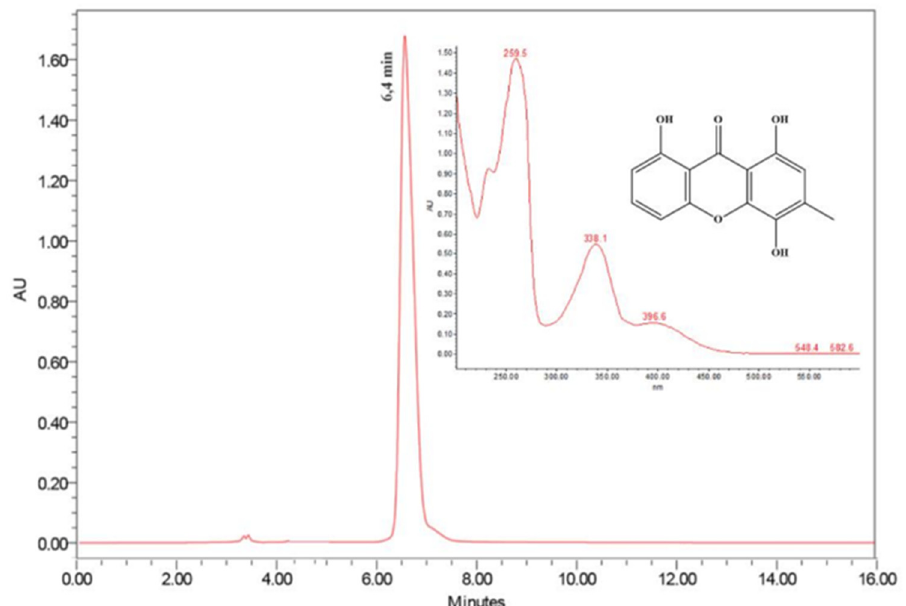
Figure 1. Preparative HPLC-PAD chromatogram at 254 nm of fraction A3 obtained of ethyl acetate from E. rostratum. UV-Vis spectrum of ravenelin (t R = 6.4 min). Sunfire™ prep C18 OBD column (5 µm, 19 mm × 150 mm), 500 µL of injected volume of the sample, gradient elution H 2 O/MeOH (90–100%) for 16 min, flow 9.0 mL/min, PAD range 210–600 nm.